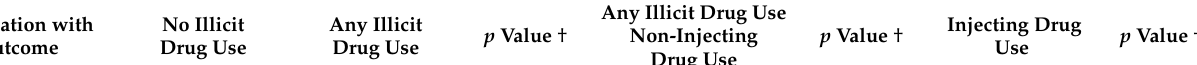
Table 5. Association of prior illicit drug use with past-year suicidal behaviors, and past-year household food insecurity. Association with